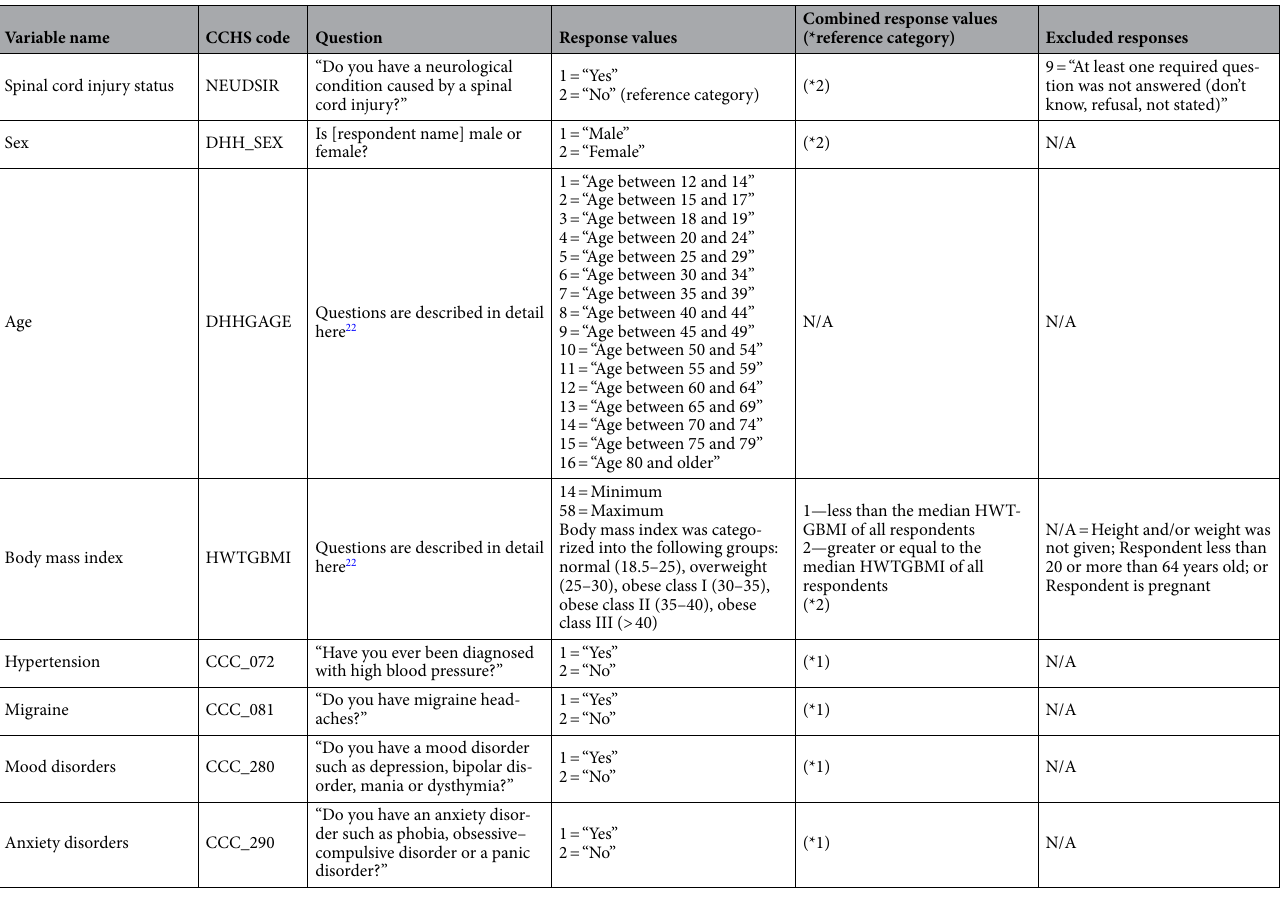
Table 4. Spinal cord injury status, sex, age, body mass index and comorbidities. CCHS Canadian Community Health